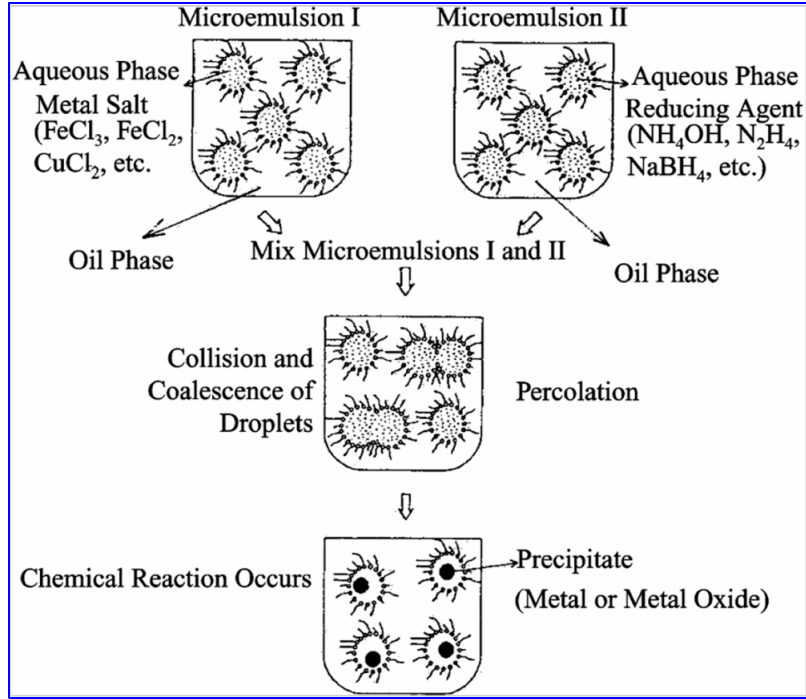
Figure 3. Proposed mechanism for the formation of metal particles from the microemulsion method using the two microemulsions protocol. Reprinted with permission from Ref. [45]. Copyright 2004,